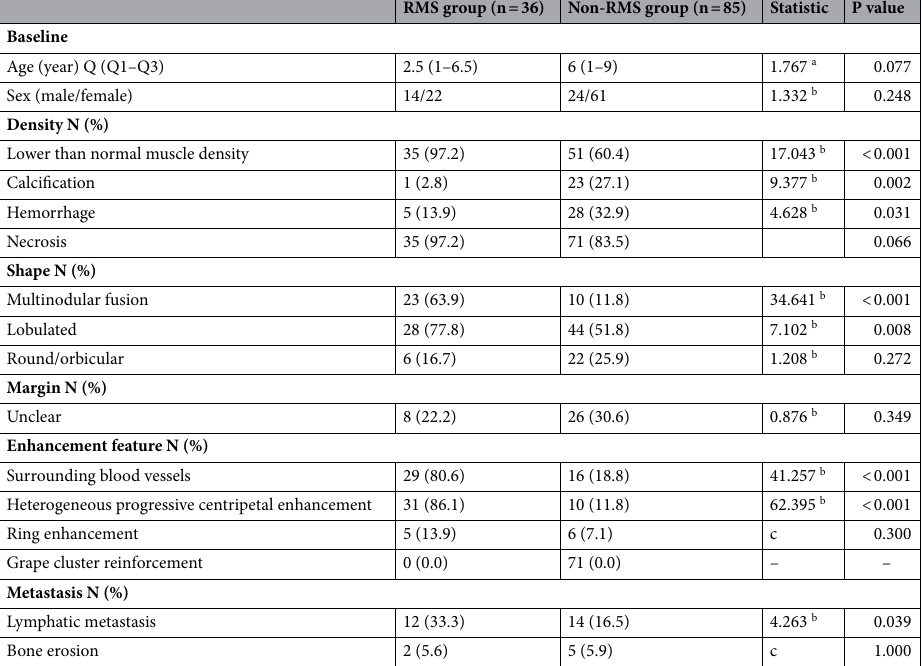
Table 1. Comparison of the basic and CT morphological characteristics between the RMS group and the non-RMS group. Q is the median age, Q1–Q3 are 25–75% quantiles. CT computed tomography, RMS